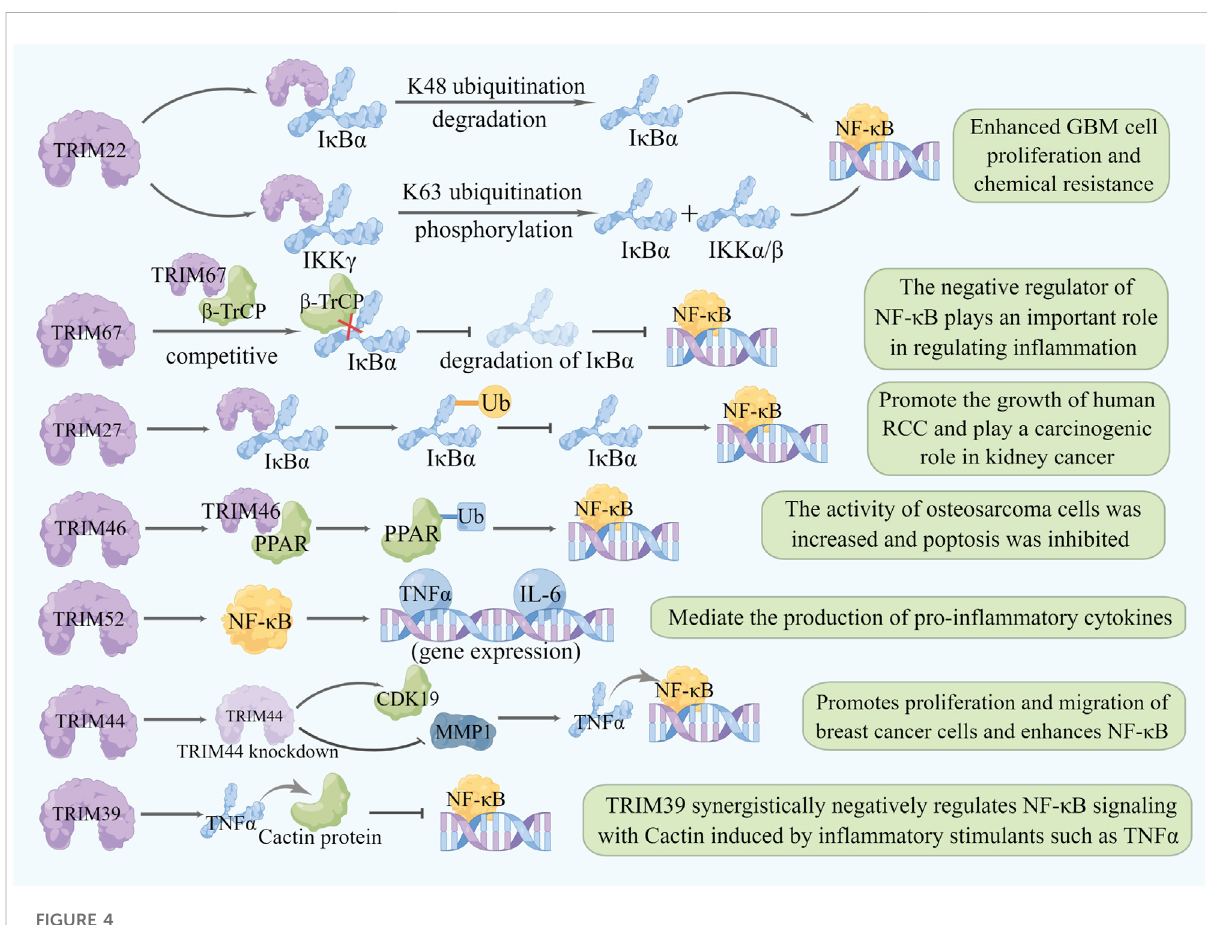
FIGURE 4 RelationshipbetweenTRIMsandNF- κ B.TRIMproteinsregulatetheNF- κ Bpathwaybyaffectingdifferenttargetgenesandplaydifferentrolesin differentcancers.Degradationofatargetgeneorproteinknockdownisrepresentedbyalighteningofthecolorofthesamepattern.TRIM22bindsto I κ B α to accelerate the degradation of K48-linked ubiquitination, and forms a complex with IKK γ to promote the ubiquitination of K63 linked ubiquitination, which leads to the phosphorylation of IKK α / β and I κ B α and activates the expression of NF- κ B. TRIM67 binds to β -TrCP, competitively inhibits the binding of β -TrCP and I κ B α , inhibits the degradation of I κ B α , and inhibits the expression of NF- κ B. TRIM27 interacts with I κ B α to ubiquitinate it and inhibit its activity, leading to the activation of NF- κ B. TRIM46 can interact with PPAR and activate the NF- κ B signaling pathway through ubiquitination of PPAR. TRIM52 speci fi cally activates NF- κ B signaling and promotes the expression of TNF α and IL-6. TRIM44 knockdown upregulated CDK19, downregulated MMP1, and impaired TNF α -stimulated NF- κ B-mediated transcriptional